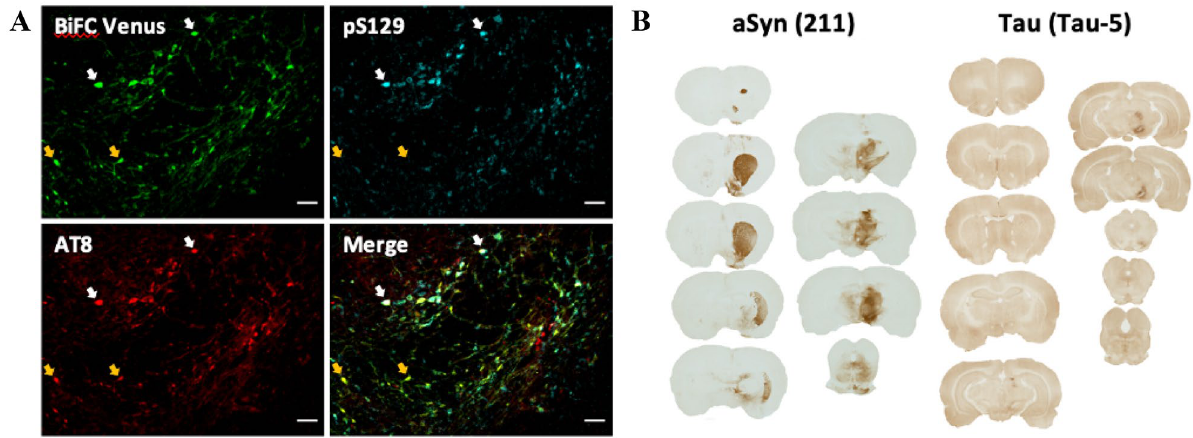
Figure 4. Molecular characterization of aSyn-Tau interaction in rat SNpc. aSyn-Tau interaction in rat SNpc. Eight weeks after co-injection of VN-aSyn and Tau WT-VC in rat SNpc immunohistochemistry was performed. ( A ) Immunohistochemistry for phosphorylated epitopes of aSyn (pS129) and Tau (AT8) suggests that aSyn and Tau can be phosphorylated while they are interacting with each other. Scale bar: 50 µm ( B ) Distribution of aSyn and Tau after injection of VN-aSyn and Tau WT-VC in rat SNpc. aSyn distribution shows a clear transport of aSyn from the injected area to the striatum. In contrast, the expression of human Tau seems to be confined to the